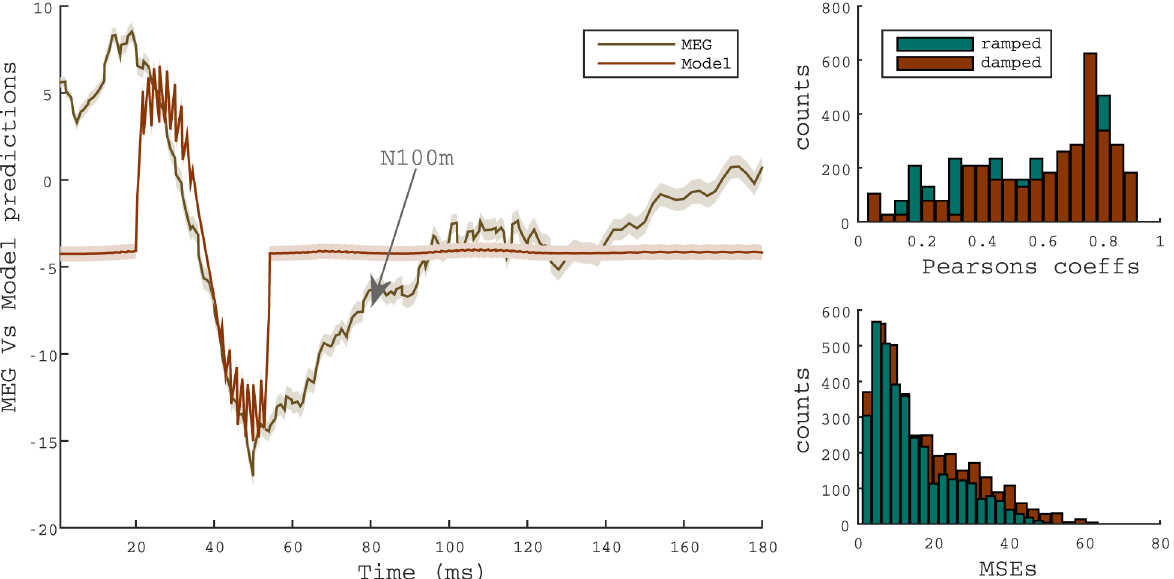
Fig 8. Summary of the statistics of the fit between the N100m transient and the output of GPM. Left panel: Example of the model response derivative, normalized to the amplitude of the recording, for a ramped stimulus ( T 1/2 = 0.5ms) and the corresponding recordings, averaged across right and left hemispheres and participants. Transparent shadows represent standard deviations. Right panel: Histograms of the Pearsons ’ s correlation coefficient and root-mean-square errors corresponding to the fittings between the GMP prediction and MEG recordings in an interval of 50 ms around the N100m peak. Each value corresponds to a single cross-validation instance for ramped and damped stimuli.